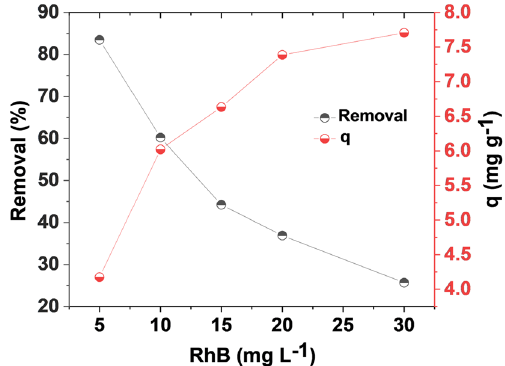
Fig. 9 The effect of RhB concentrations (5–30 mg L −1 ) for the